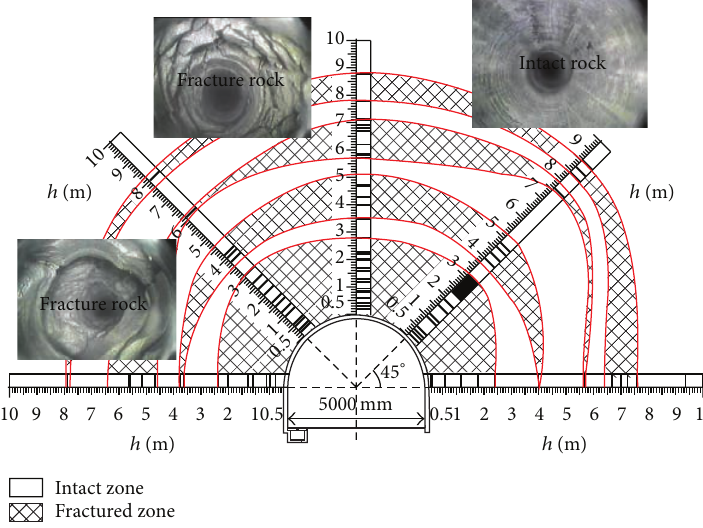
Figure 3: Zonal disintegration of Dingji coal mine of Huainan mine area.